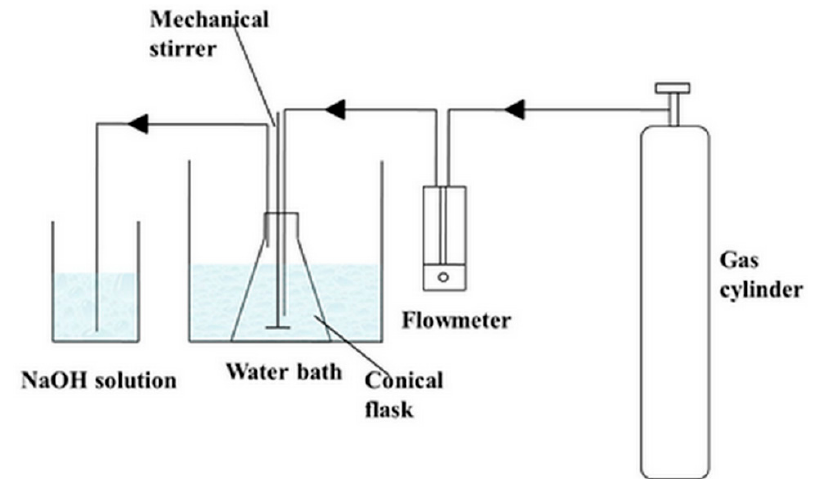
Figure 1. Schematic diagram of the aqueous carbonation experimental system .